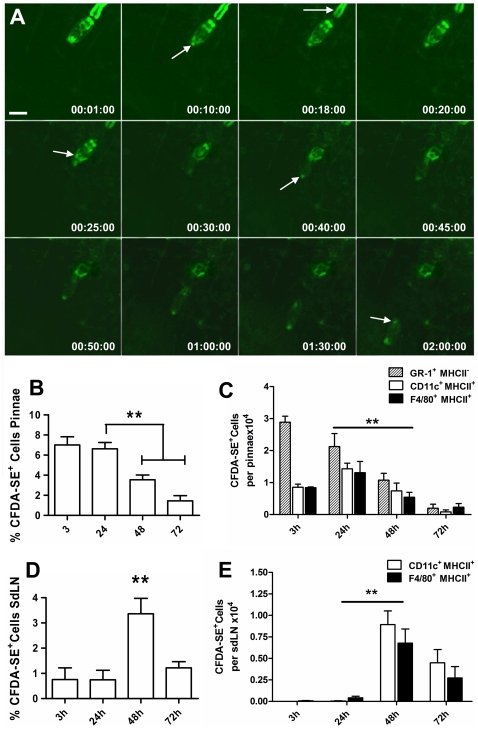

In vivo infection with CFDA-SE-labelled cercariae results in the release of labelled material in skin and its uptake by cells in the skin and sdLN.A; Stills from a time-lapse video (see supplementary Video S4) showing confocal images of a CFDA-SE-labelled infective cercaria penetrating and migrating through a mouse pinna, (scale bar = 100 µM). Attachment of the cercaria to the stratum corneum at 00:01:00, the loss of its tail by 00:18:00, penetration through outer layers of epidermis and deposition of gland material through 00:10:00 and onward migration up to 2 hours post-infection 02:00:00. B; Pinnae from mice infected with CFDA-SE labelled cercariae were digested and skin cell suspensions enumerated for CFDA-SE+ cells by flow cytometry (significant difference compared to 3 hrs). C; Phenotype of CFDA-SE+ cells from digested skin of pinnae exposed to CFDA-SE labelled cercariae showing uptake by GR-1+ MHC-II−, F4/80+ MHC-II+, and CD11c+ MHC-II+ cells. D; Phenotype of CFDA-SE+ cells from the sdLN of the same mice above showing uptake by F4/80+MHC-IIl+, and CD11c+MHC-II+ cells with a significant increased level of CFDA-SE+ cells present at 48 hrs (** denotes p = <0.01). Data in B–D is represents data from 6 different mice.